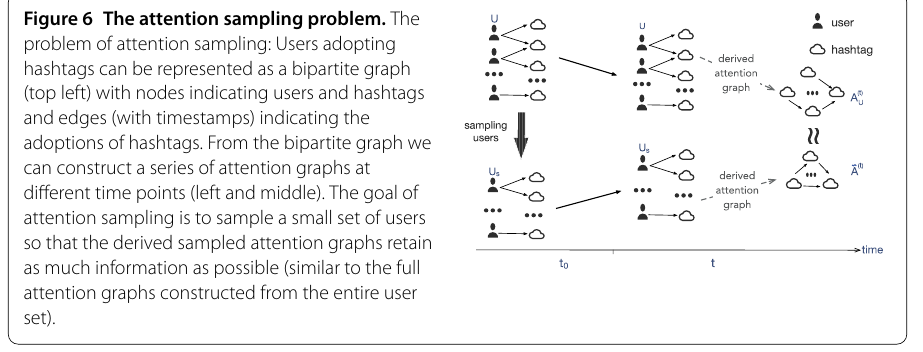
Figure 6 The attention sampling problem. The problem of attention sampling: Users adopting hashtags can be represented as a bipartite graph (top left) with nodes indicating users and hashtags and edges (with timestamps) indicating the adoptions of hashtags. From the bipartite graph we can construct a series of attention graphs at different time points (left and middle). The goal of attention sampling is to sample a small set of users so that the derived sampled attention graphs retain as much information as possible (similar to the full attention graphs constructed from the entire user